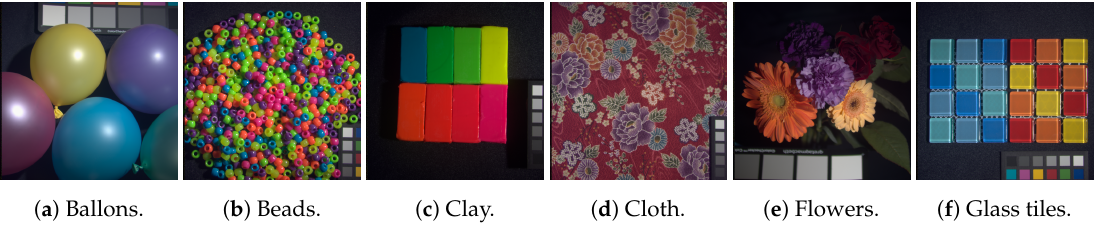
Figure 2. RGB representations of the multispectral sets from the CAVE dataset used in this work for